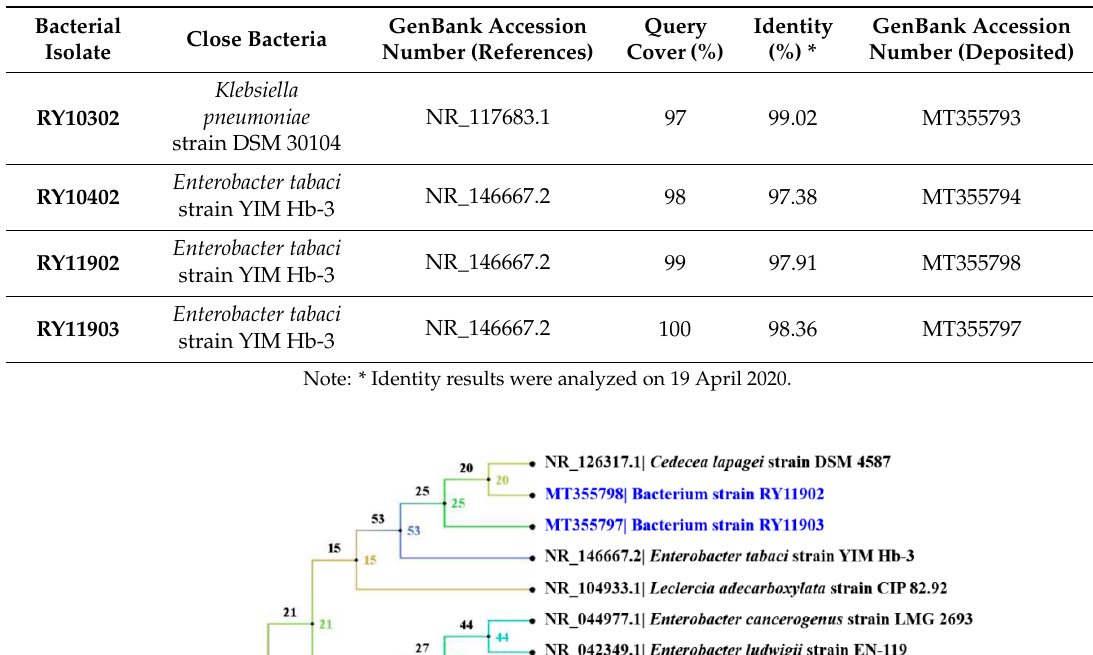
Table 3. Identity percentage of 16S rRNA gene sequences for the four dye-decolorizing bacteria.